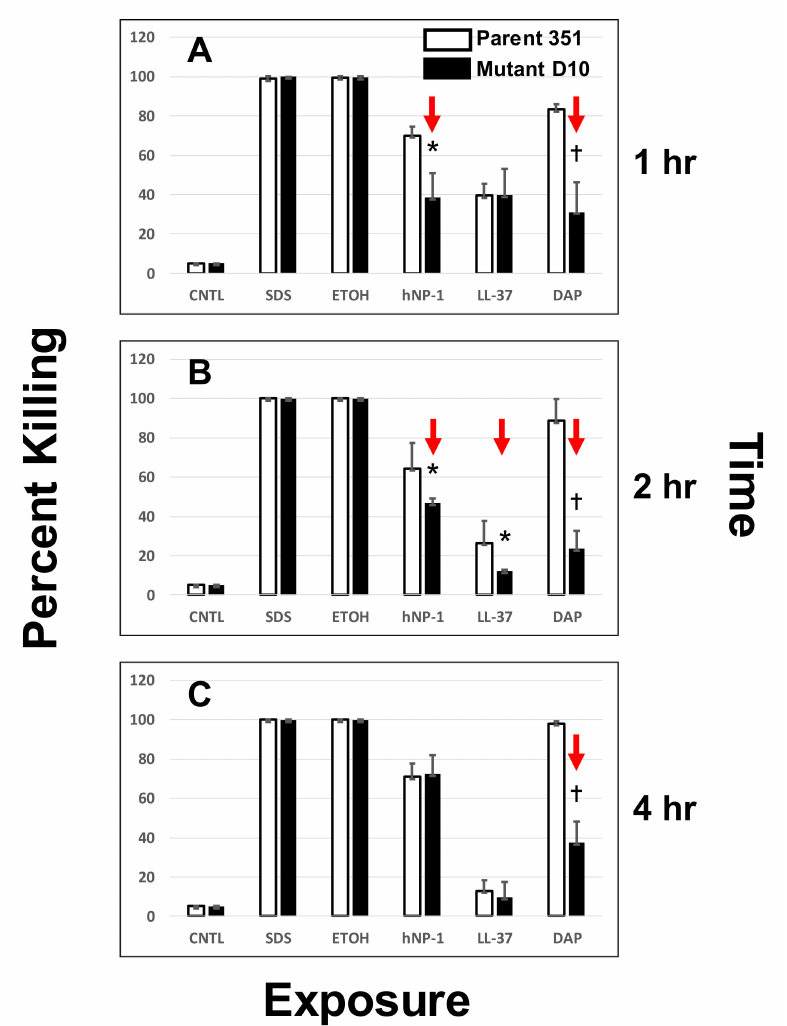
Figure 2. Kinetics of DAP and HDP susceptibilities of study strains DAP-S and 351-D10 DAP-R at 1, 2 or 4 h (panels ( A ), ( B ) or ( C ), respectively) in vitro. Exposure conditions and quantitative culture methods were performed as detailed in the Methods Section. Significant differences in strain susceptibilities (red arrows) represent p < 0.01 (†) or p < 0.05